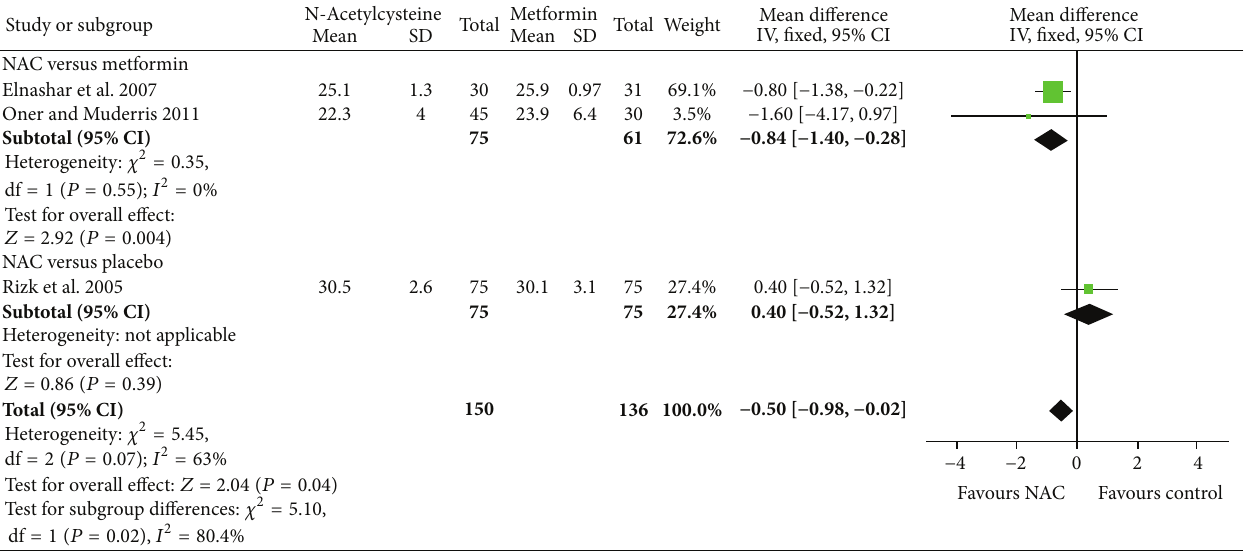
Figure 7: Forest plot: outcome: body-mass index (BMI) (kg/m 2 ) in women with PCOS comparing NAC with